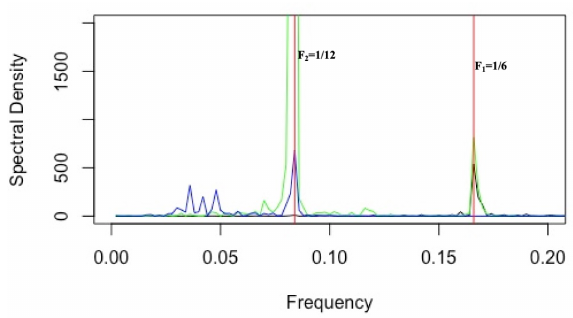
Figure 7. TCO IMF 1 (black line), IMF 2 (green line) and IMF 3 (blue line) spectral contents.